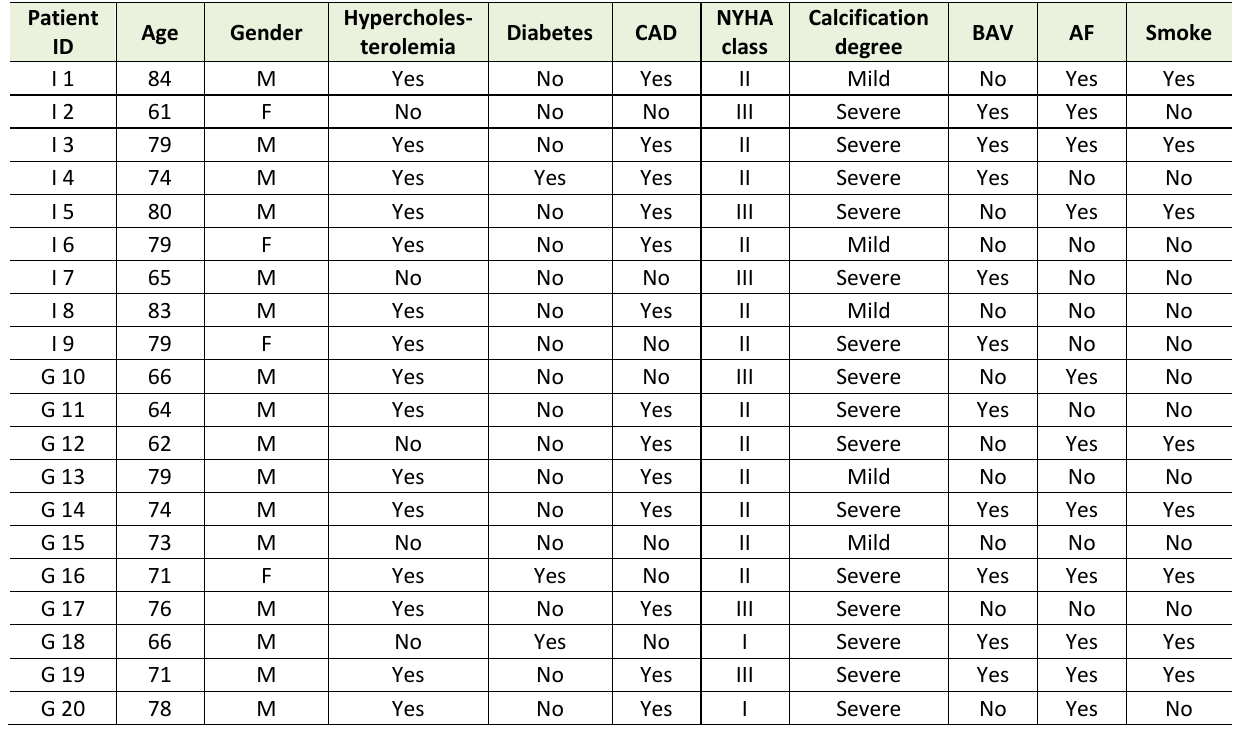
TABLE 1. Clinical information of the enrolled Italian (I) and German (G) patients.